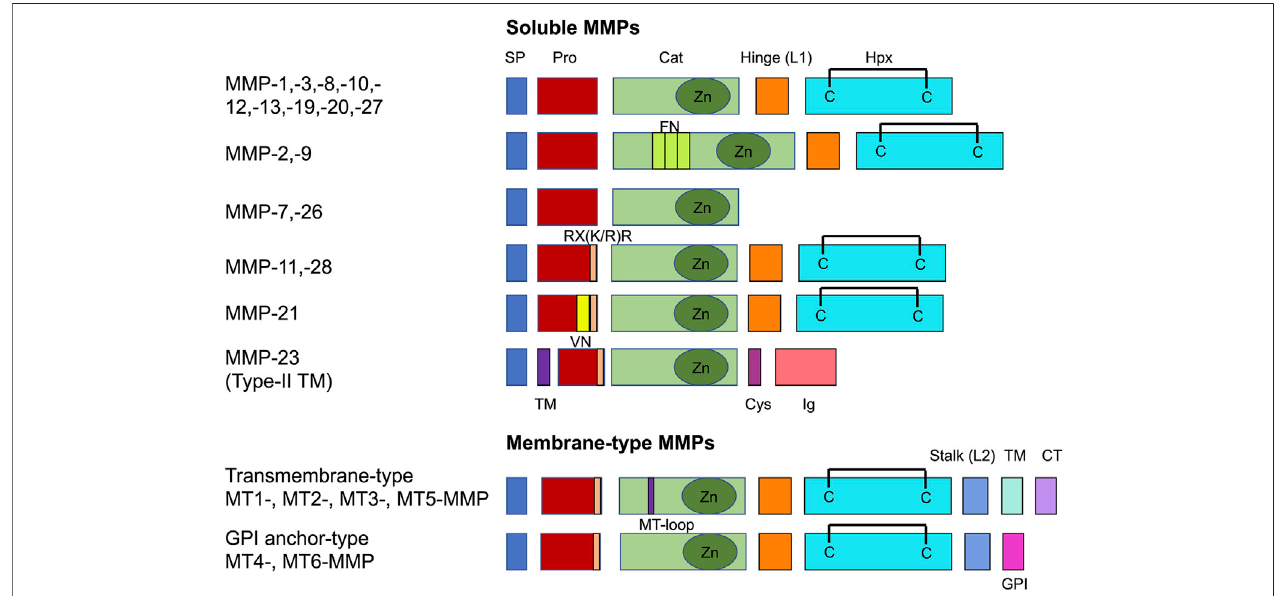
FIGURE 3 | Common domain structure of the MMP family. There are two major classes, such as soluble MMPs and membrane-bound membrane-type MMPs. Catalytic domain (Cat), cysteine-rich domain (Cys), cytoplasmic tail (CT), fi bronectin type II repeats (FN), GPI-anchor signal sequence (GPI), hemopexin domain with a C-C disul fi de bond (Hpx), immunoglobulin-like domain (Ig), linker 1 (L1), linker 2 (L2), MT-loop (cid:1) eight-amino acid insertion characteristic to TM-type MT-MMPs, pro- domain (Pro), RX(K/R)R (cid:1) PC recognition sequence, signal peptide (SP), transmembrane domain (TM), vitronectin-type domain